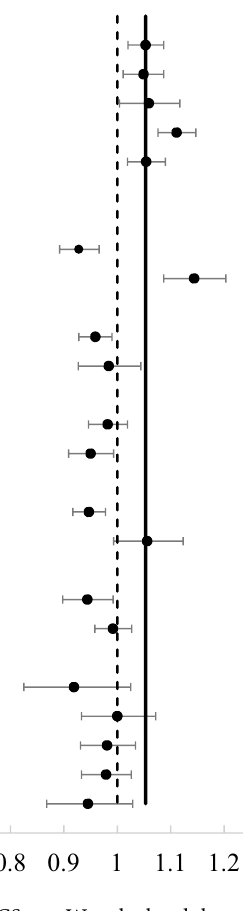
Figure 2. Sensitivity analysis and subgroup analysis of osteoporosis risk with ICS use. We calculated the sensitivity analysis and subgroup analysis for the risk of osteoporosis with ICS use, stratified by the potential